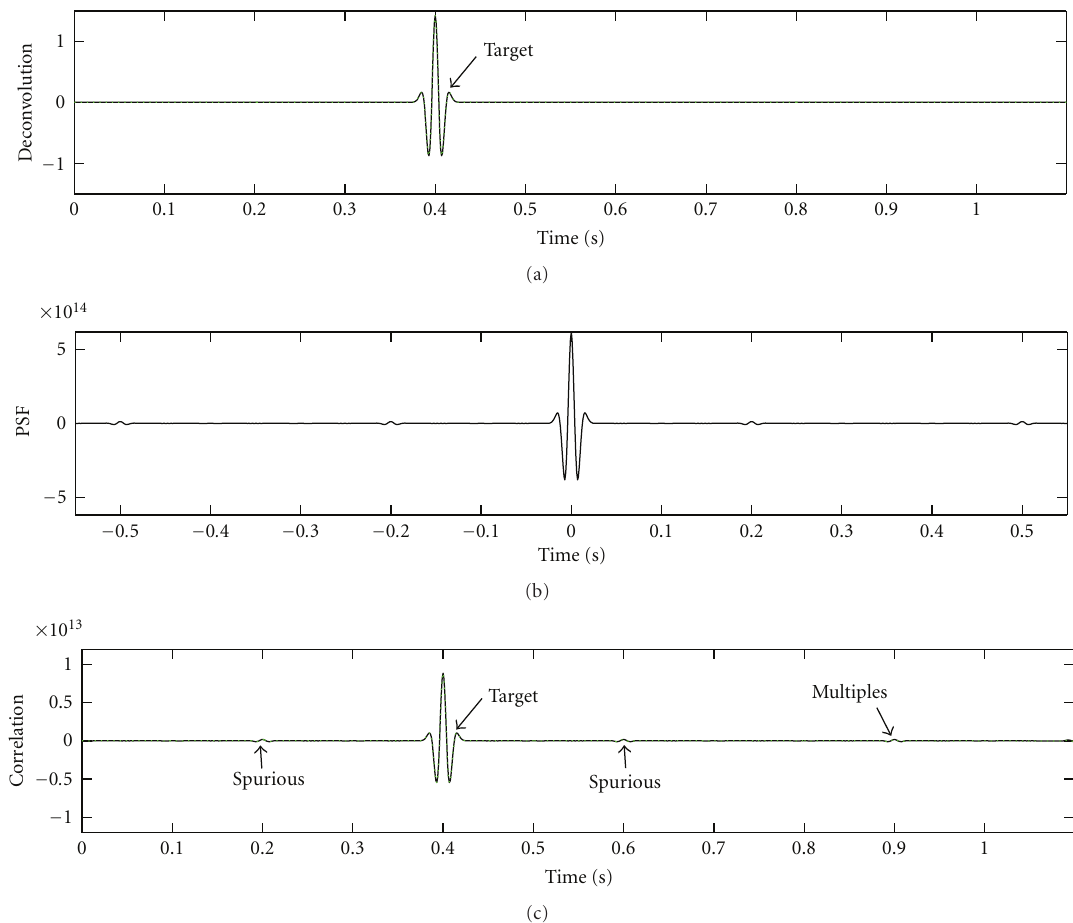
Figure 17: Deconvolution of decomposed fields for model B: (a) retrieved Green’s function (black) and the reference response (dashed green); (b) point spread function Γ dcp ; (c) convolution of the reflection response with the PSF (black) and the correlation function C dcp (dashed